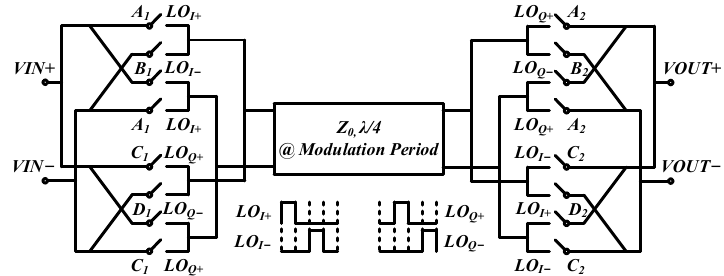
Figure 1. Gyrator using 25% duty-cycle clock signal.